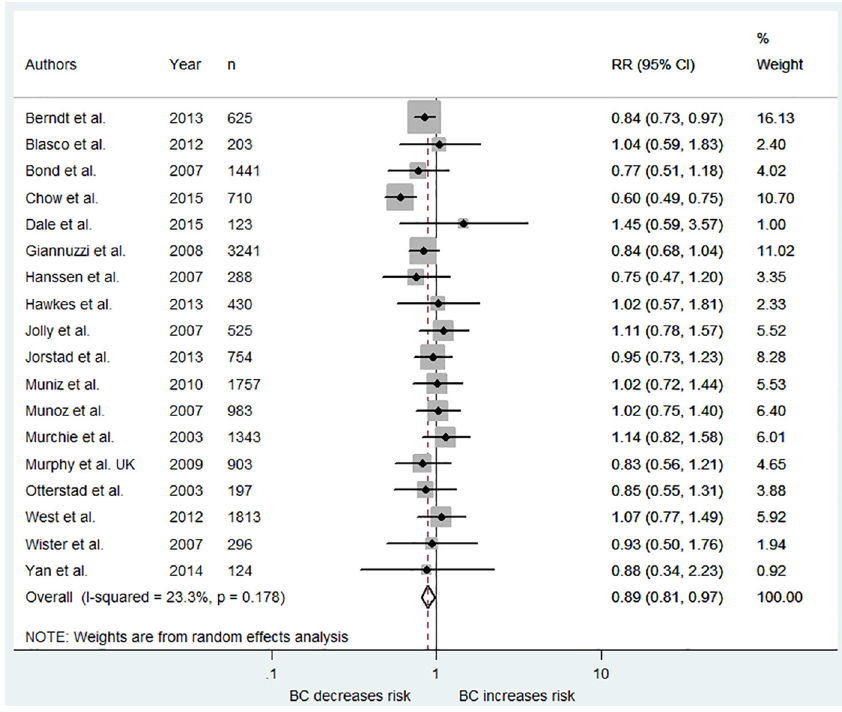
Fig 3. Forest plot showing weighted risk ratio for